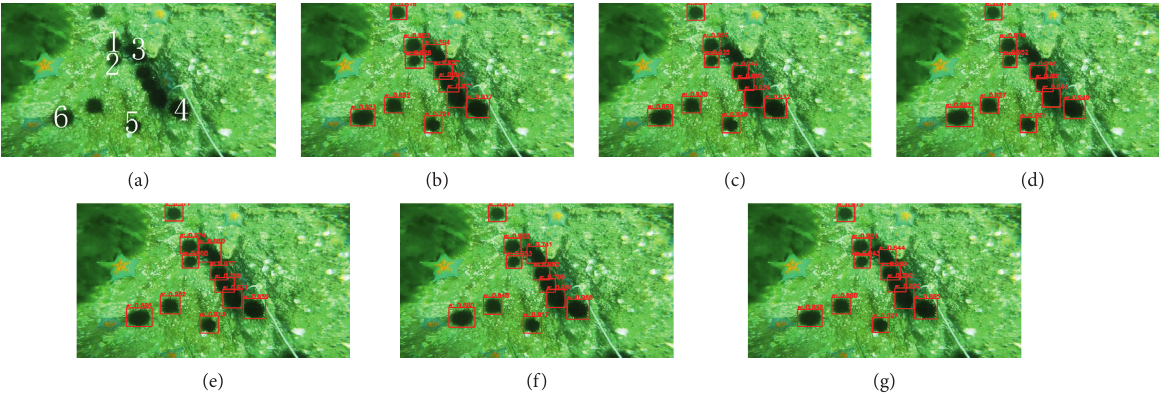
Figure 10: Multidirectional detection target detection result graph of ISSD, (a) the confidence test graph of sea urchin (Laplace operator unidirectional), (c) the confidence test graph of sea urchin (Prewitt operator 2 directions), (d) the confidence test graph of sea urchin (Prewitt operator 4 directions), (e) the confidence test graph of sea urchin (Prewitt operator 8 directions), (f) the confidence test graph of sea urchin (Prewitt operator 16 directions), and (g) the confidence test graph of sea urchin (Sobel operator 2